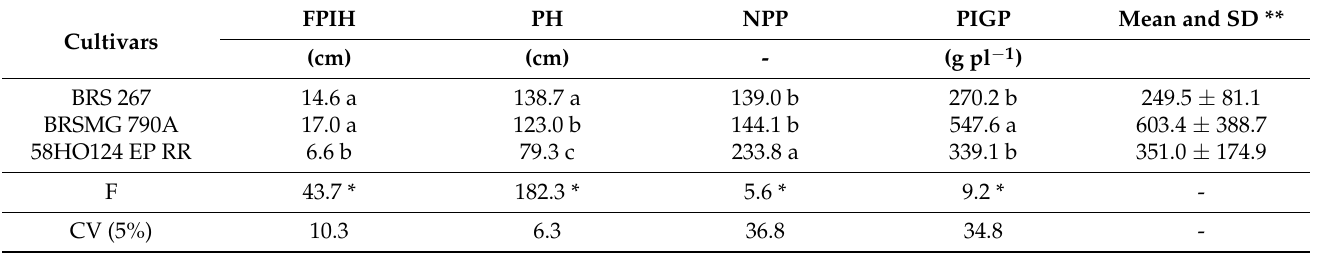
Table 4. Averages from the first pod insertion height (FPIH), plant height (PH), number of pods per plant (NPP), production of immature grains per plant (PIGP). Botucatu, SP, Brazil, 2021.